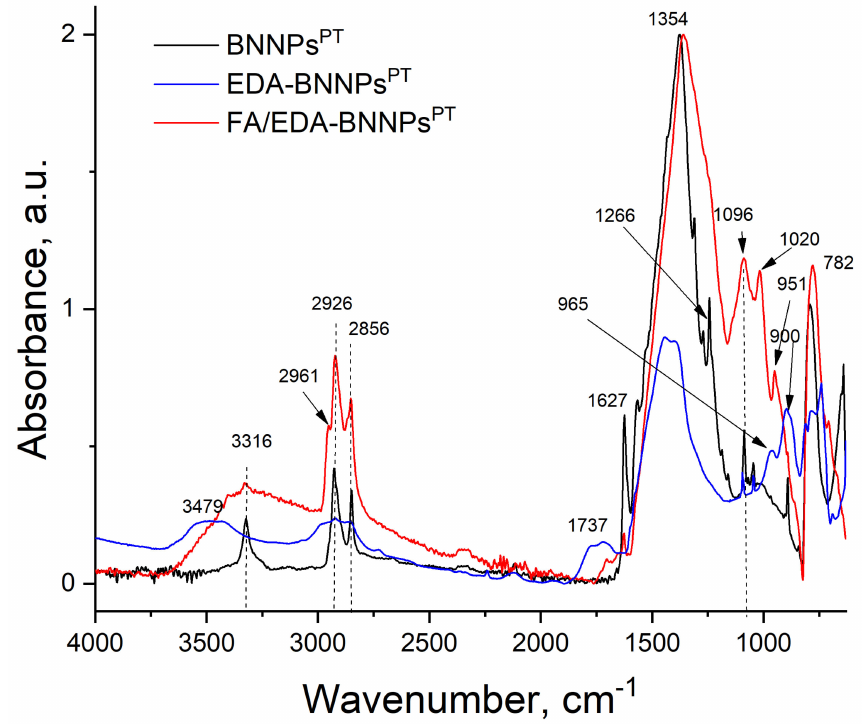
Figure 3. FTIR spectra of functionalized